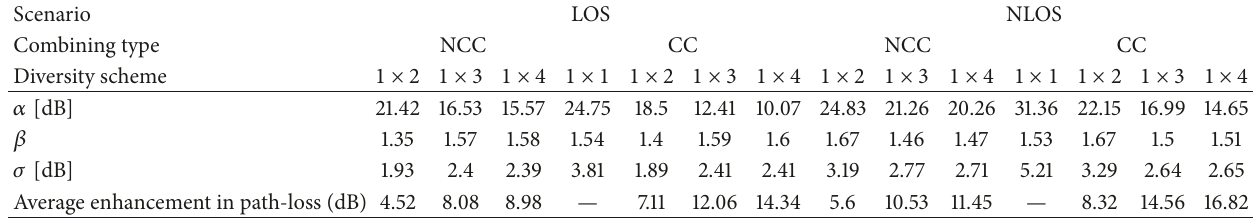
Average enhancement in path-loss (dB) 4.52